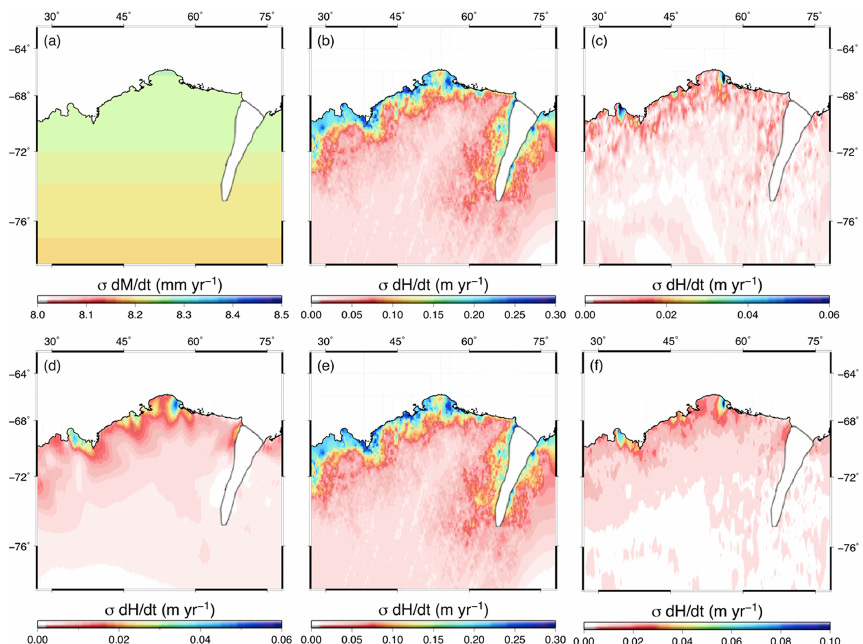
Figure 7. Uncertainties estimated for (a) GRACE, (b) ICESat, (c) our monthly firn compaction model, ice dynamic rates using RACMO2.3 obtained from (d) GRACE and (e) ICESat, and the modelled surface elevation trend for (f) RACMO2.3. The greatest uncertainty comes from the ICESat measurements, with up to 30cmyr − 1 at the margins; this results in greater uncertainties for the modelled ice dynamic rates obtained from the ICESat